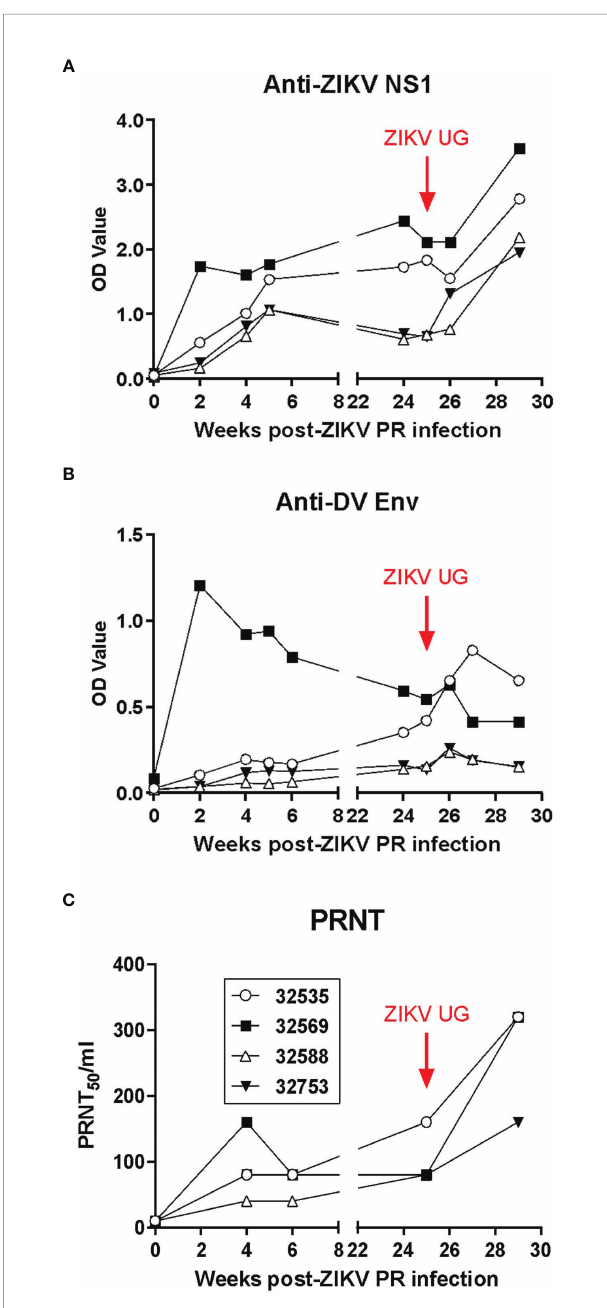
FIGURE 4 | Humoral immune responses to ZIKV in exposed baboons. (A) ELISA anti-ZIKV NS1 IgG levels. (B) ELISA cross-reactive anti-Dengue virus GP IgG antibodies. (C) Plaque-reduction neutralization test (PRNT) on longitudinally collected baboon plasma. Baboons were challenged with the virus in either a high dose of 10 6 TCID 50 ( n = 2, open symbols) or a low dose of 10 4 TCID 50 ( n = 2, closed